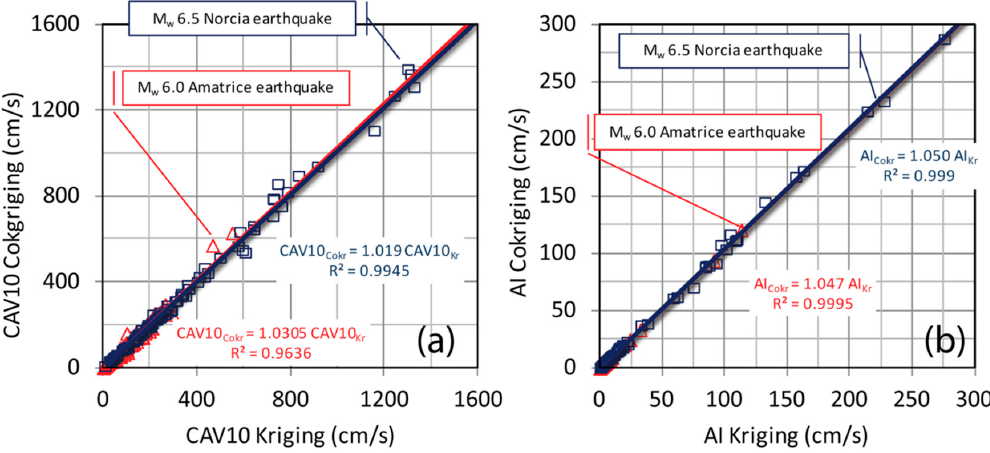
Figure 6. Cross-correlation between kriging and cokriging methods for CAV10 ( a ) and AI ( b ).